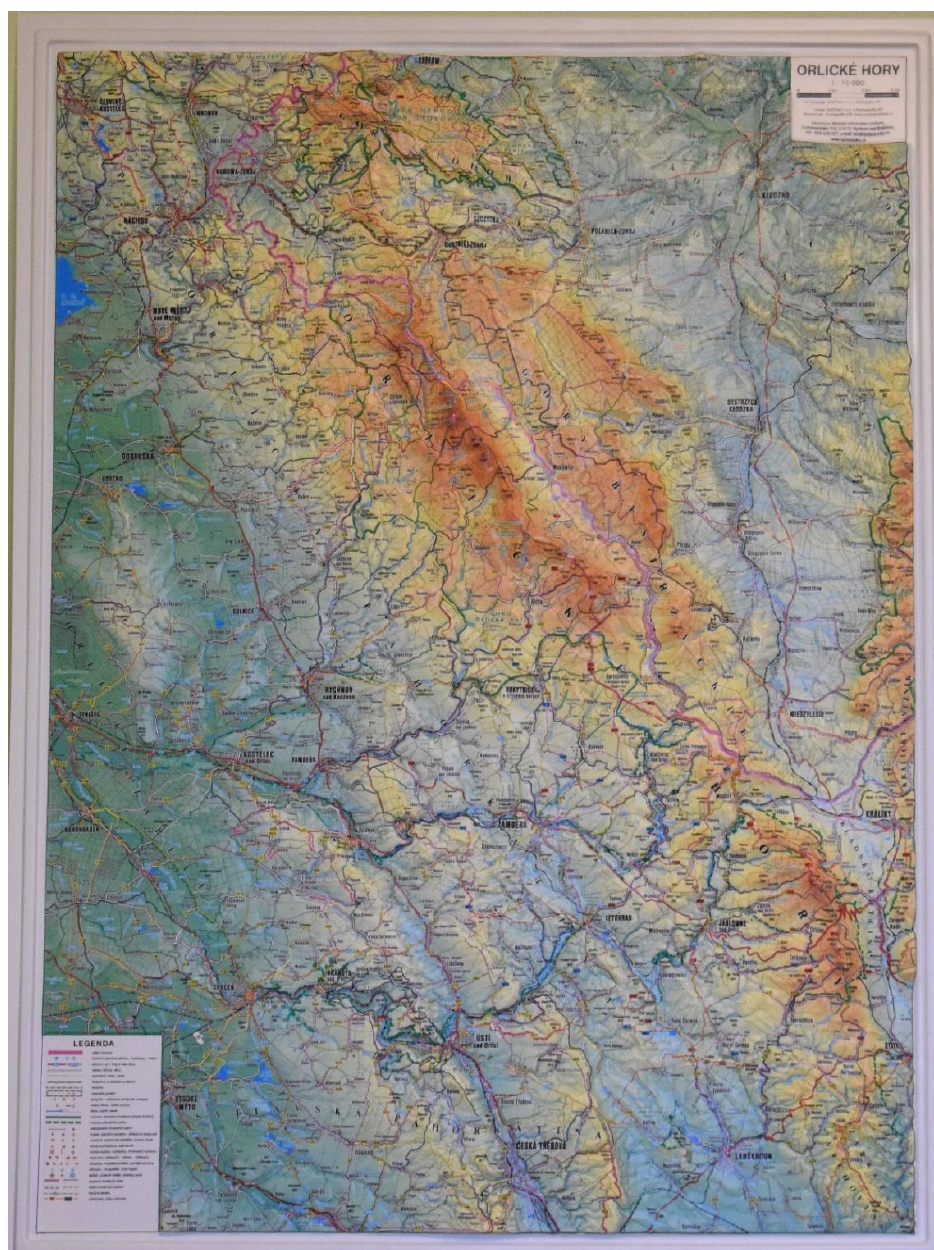
Figure 10. Three-dimensional relief map of the Orlick é –Bystrzyckie Mountains Block, commercially available. Original scale is